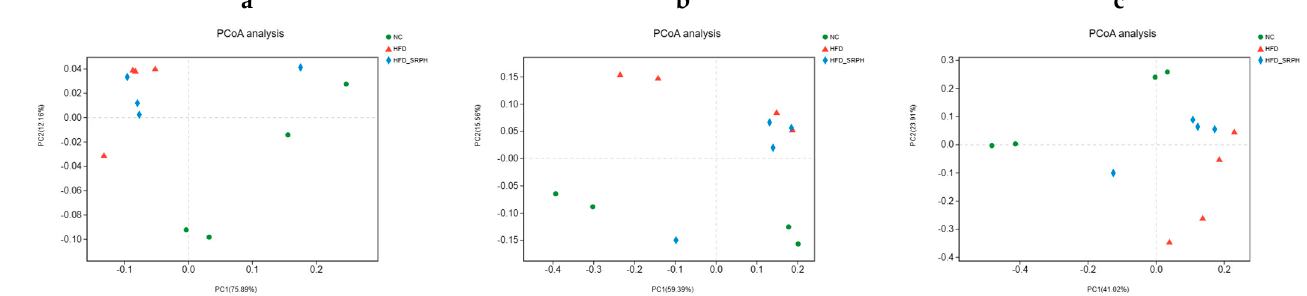
Figure 3. Fecal samples of NC, HFD, and HFD − SRPH groups were analyzed using PCoA. ( a ) PCoA of phylum. ( b ) PCoA of genus. ( c ) PCoA of species.